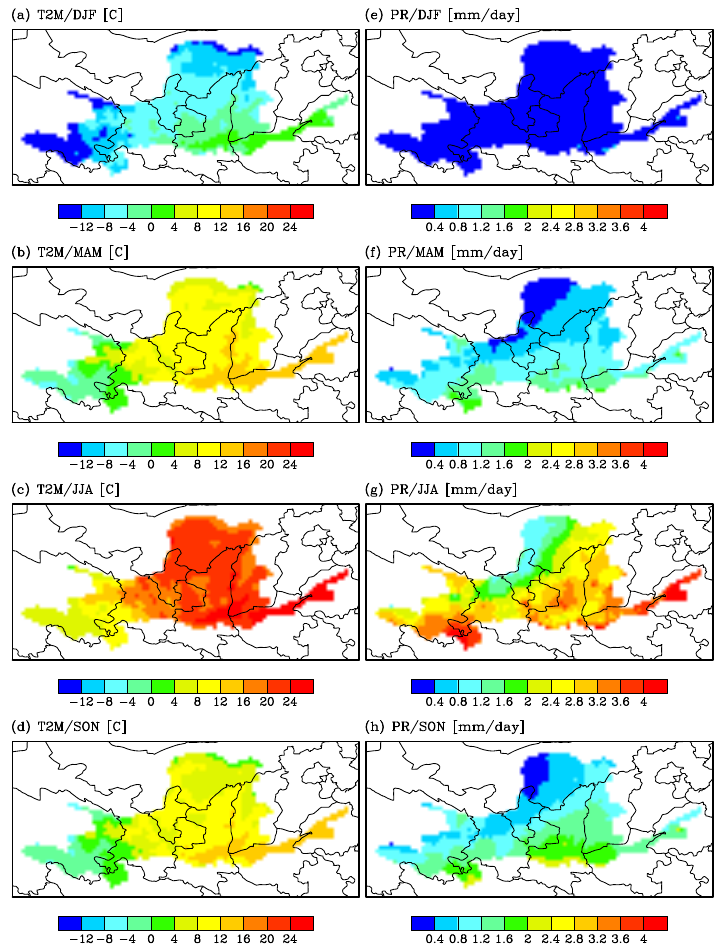
Figure 2. Seasonal mean (a–d) 2m air temperature and (e–h) precipitation over the Yellow River averaged during 1982–2014. The four seasons are December–January–February (DJF), March–April–May (MAM), June–July–August (JJA) and September–October–November